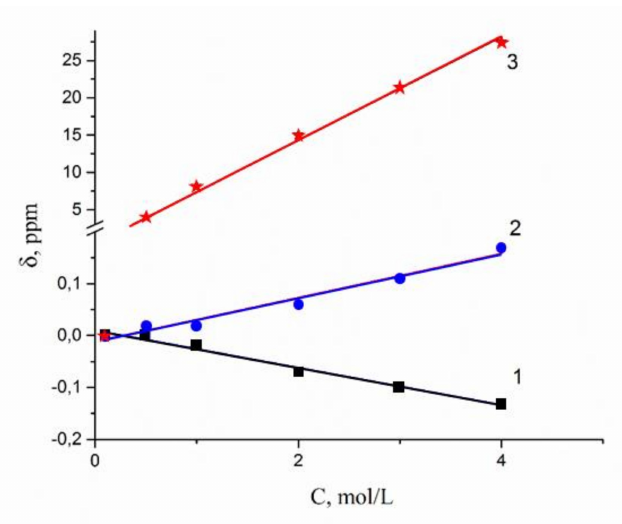
Figure 9. 7 Li (1), 23 Na (2), and 133 Cs (3) nuclear NMR chemical shift concentration dependences in lithium, sodium, cesium chloride aqueous solutions.